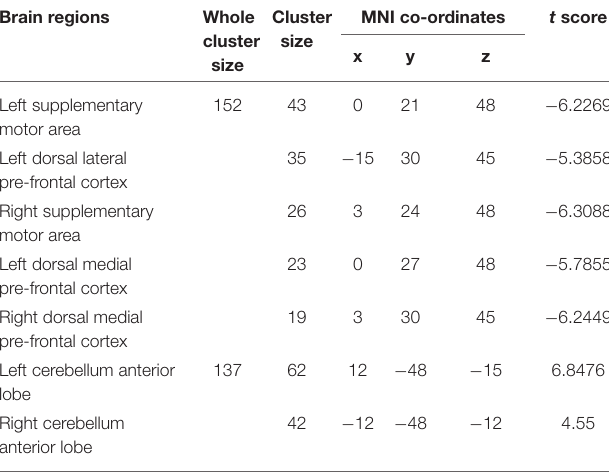
TABLE 2 | Brain regions exhibited altered ReHo in patients with chronic insomnia disorder (after training vs. before training). Brain